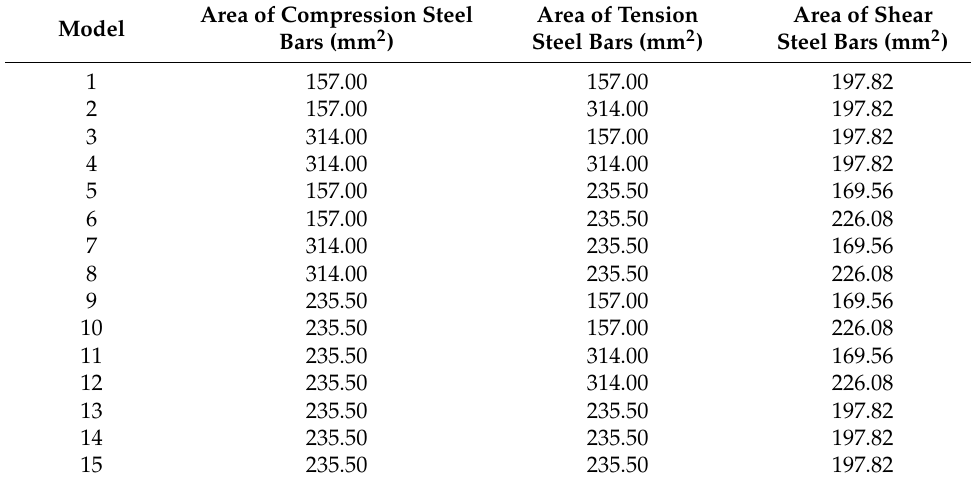
Table 2. Arrangement of 15 specimens.